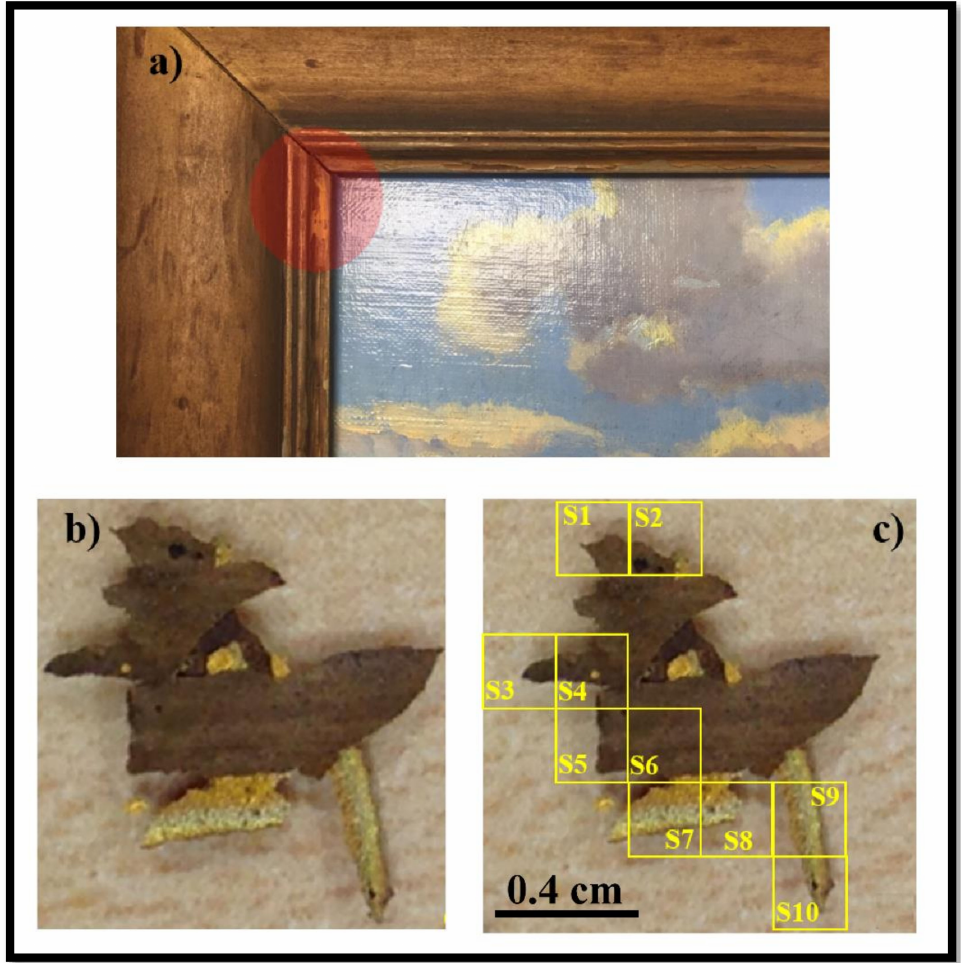
Figure 1. ( a ) The area investigated (red circle) of the frame from which the specimen was extracted, ( b ) The specimen N. 01.1622 coming from the area shown in ( a , c ) Experimental division of the specimen N. 01.1622 into the 10 different sectors representing the mapping of the spots explored by Raman